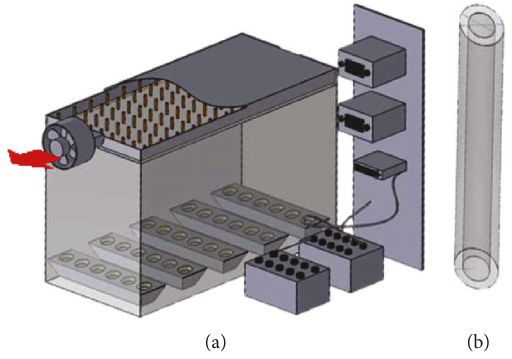
Figure 2: (a) Schematic view of the experimental setup. (b) Fin